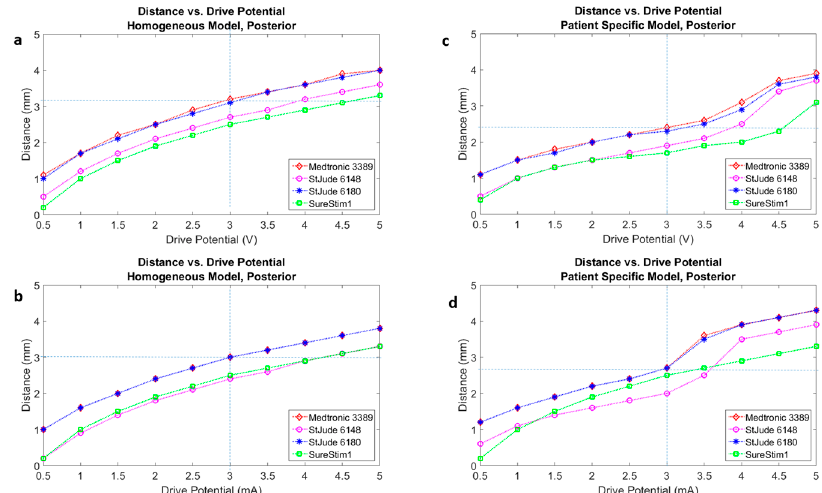
Figure 5. Activation distances for four leads mapped onto a single plot under the same test conditions of 60 µs pulse width, neuron diameter of 4 µm, configuration of all leads in 3389 lead single ring equivalent. ( a ) Homogeneous tissue model with voltage driven electrode; ( b ) Homogeneous tissue model with current driven electrode; ( c ) Patient-specific tissue model with voltage driven electrode; ( d ) Patient-specific tissue model with current driven electrode.